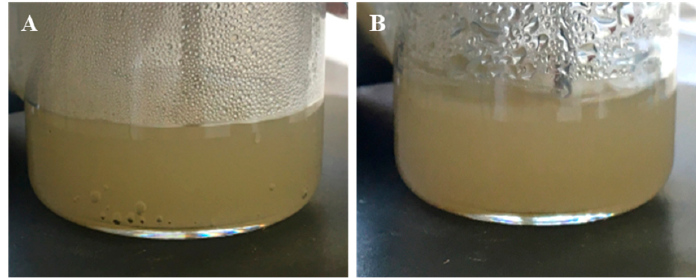
Figure 10. Images of E ‐ P3 75/25 in water at 100 °C and pH 1 ( A ) at 5 min and ( B ) at 30 min.